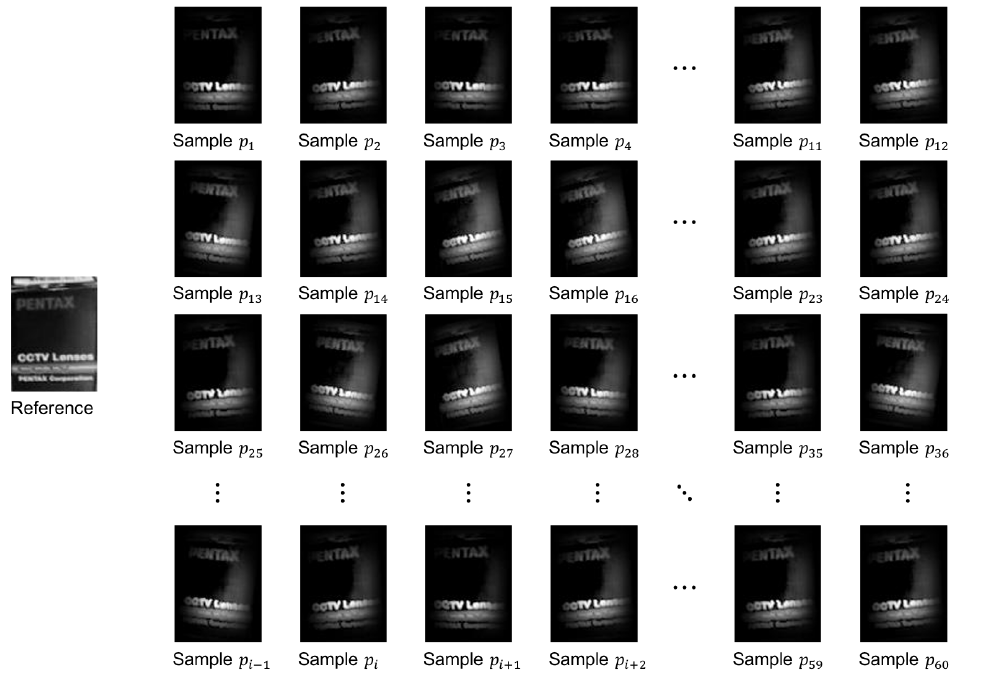
Figure 8. Affine transformation for getting reference samples p i